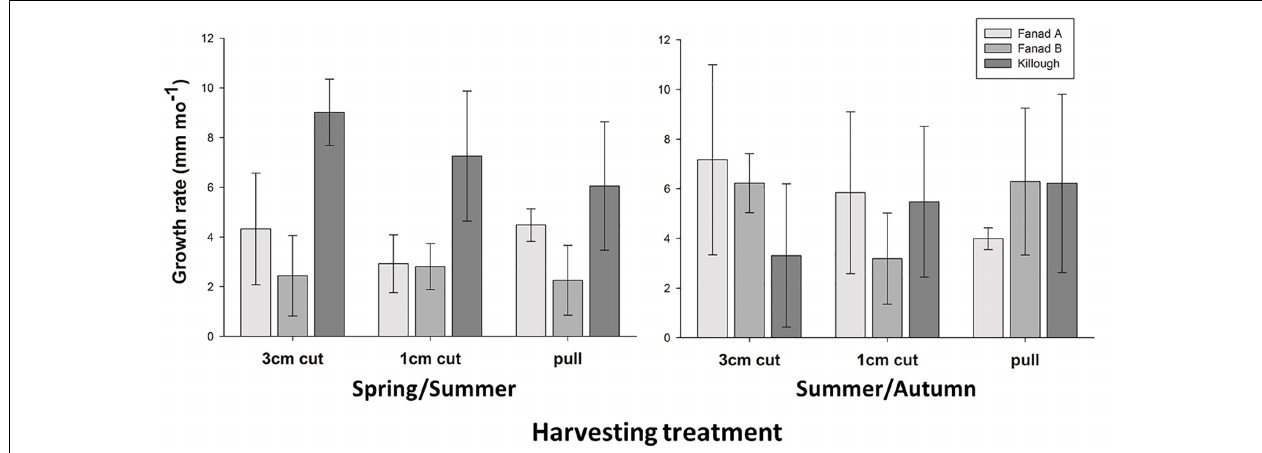
FIGURE 5 | Mean growth rates (mm mo − 1 , ± SD) of coralline algae harvested by three different methods, in three different pools in interval 1 Spring/Summer (Killough: February–July; Fanad: March–August) and interval 2 Summer/Autumn (Killough: July–November; Fanad: